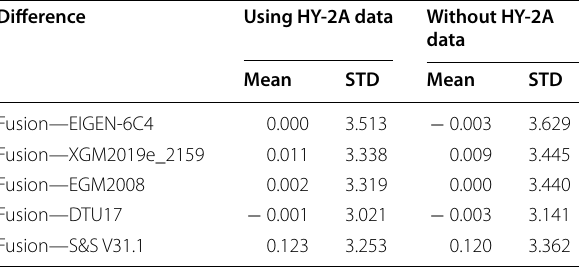
Table 11 Accuracy comparison of gravity anomaly derived using and not using HY-2A data (unit: mGal)